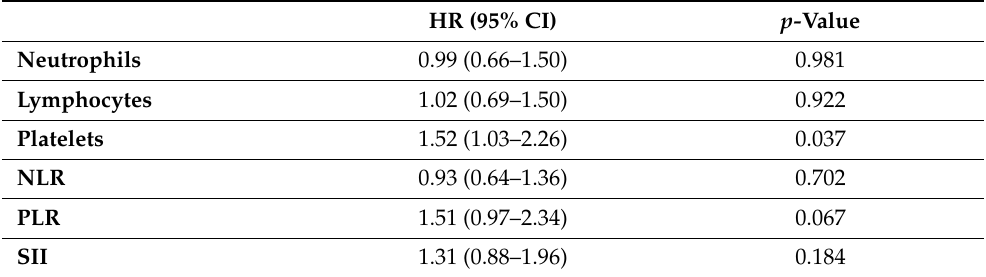
Table 5. Results from univariate Cox analysis between the inflammatory indexes and